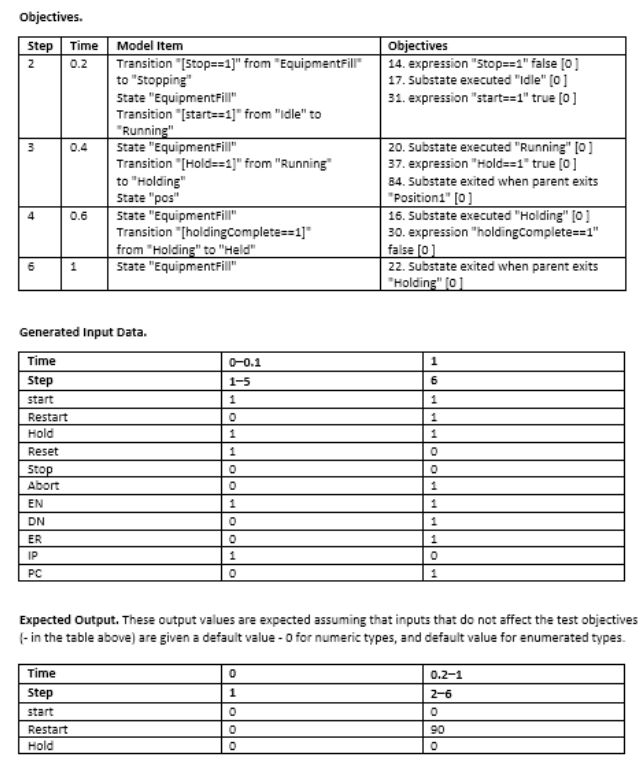
Figure A1. Example of typical test case and its associated data.